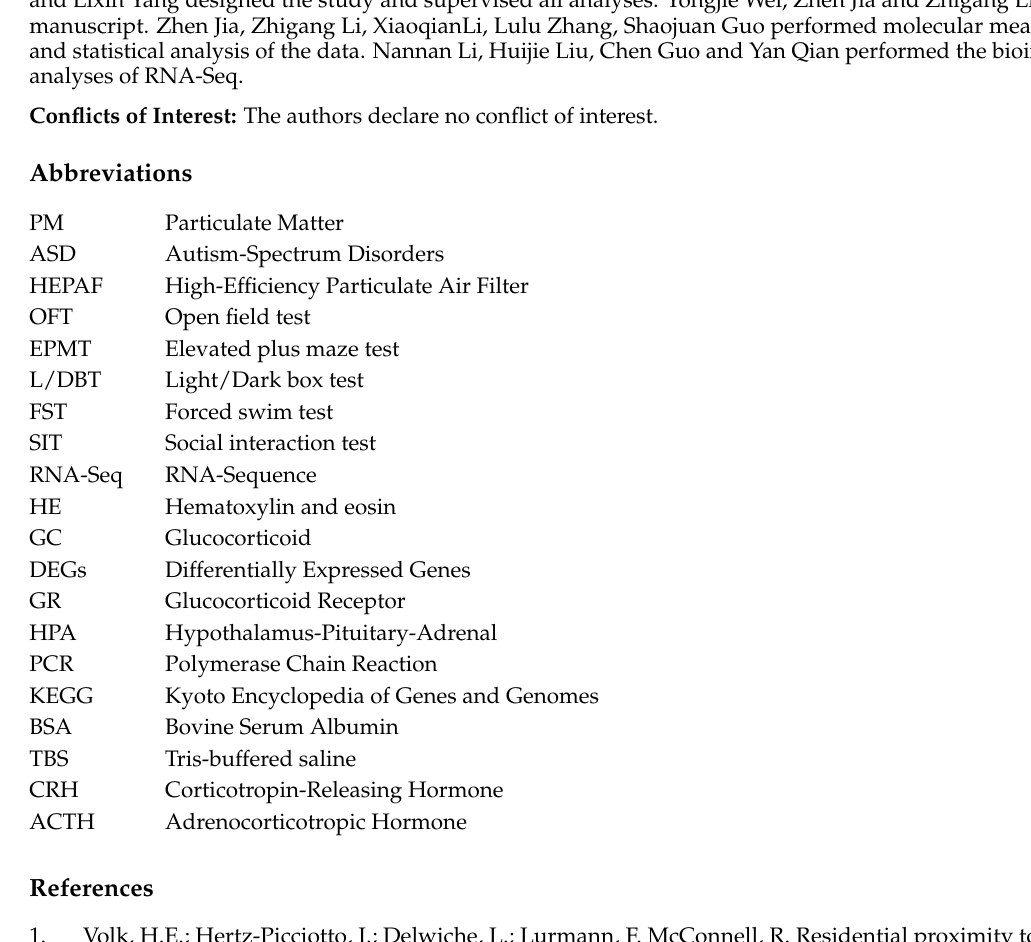
Table S4: The primer for real-time